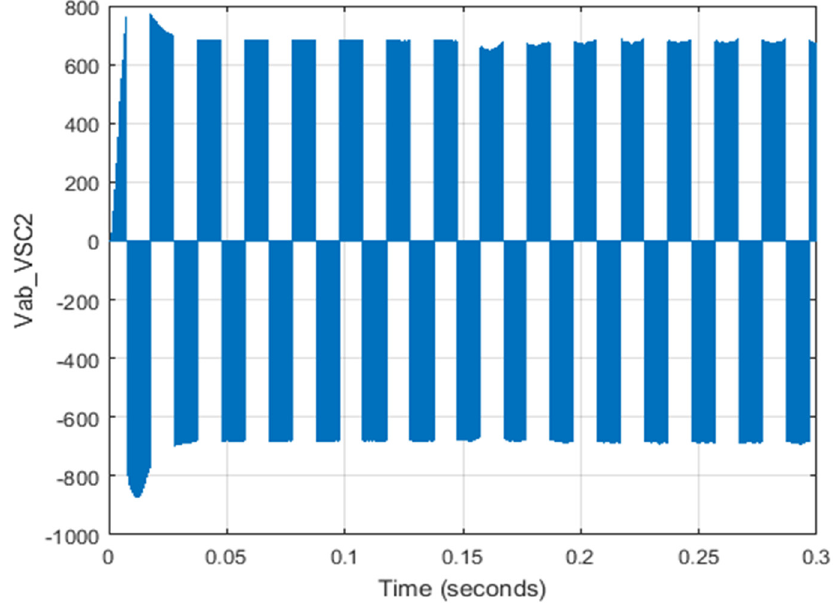
Figure 11. Two-phase voltage ab for VSC-2.